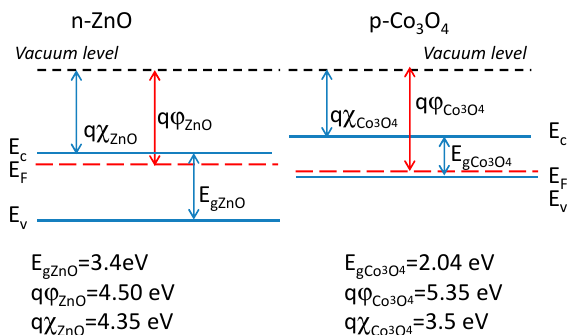
Figure 5. Electronic band diagram for the two materials. Numeric data from [39] q ϕ indicates the work function and q χ the electronic affinity, whereas Eg is the band-gap energy.